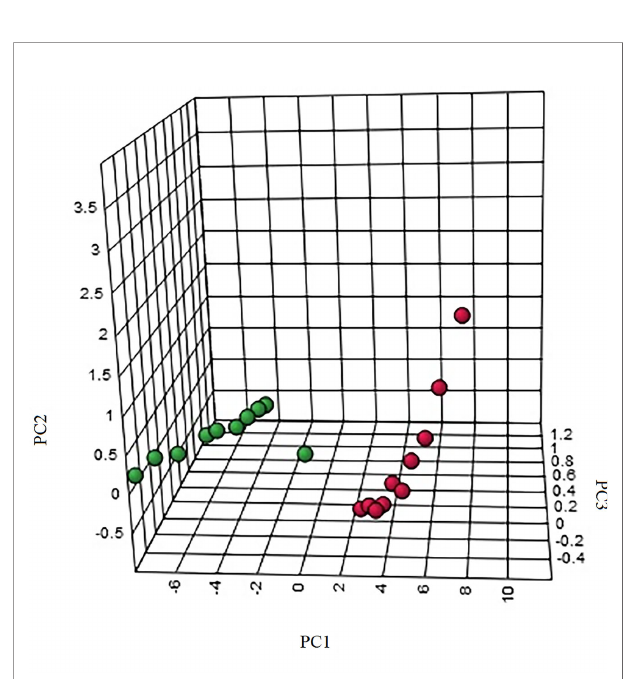
FIGURE 2 | The three-dimensional (3D) score plot of the urine samples from the control group and the model group. M, model group. The red dot indicates the control group, and the green dot indicates the model